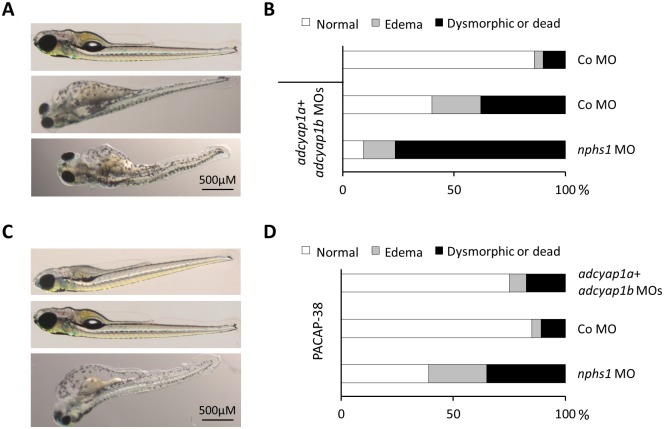
PACAP morpholino suppression and PACAP-38 rescue in nephrin depleted embryos.(A) Representative larvae of the phenotypes observed in different groups with or without PACAP (adcyap1a and adcyap1b) morpholinos injections (100 μM each). (B) Approximately 100 injected embryos per condition were live-screened at 4 dpf and assigned to a phenotype category. Compared to the control morpholino injection alone, PACAP morpholinos produced a harmful effect when injected together with the control morpholino and a devastating effect with the nphs1 morpholino. (C) Representative larvae of the phenotypes observed in different groups with human PACAP-38 injection (5μM). (D) Approximately 100 injected embryos per condition were live-screened at 4 dpf and assigned to a phenotype category. Human PACAP-38 could rescue to a great extent the PACAP morpholino injected embryos; however, they produced no beneficial effect on the nphs1 morpholino injected embryos.